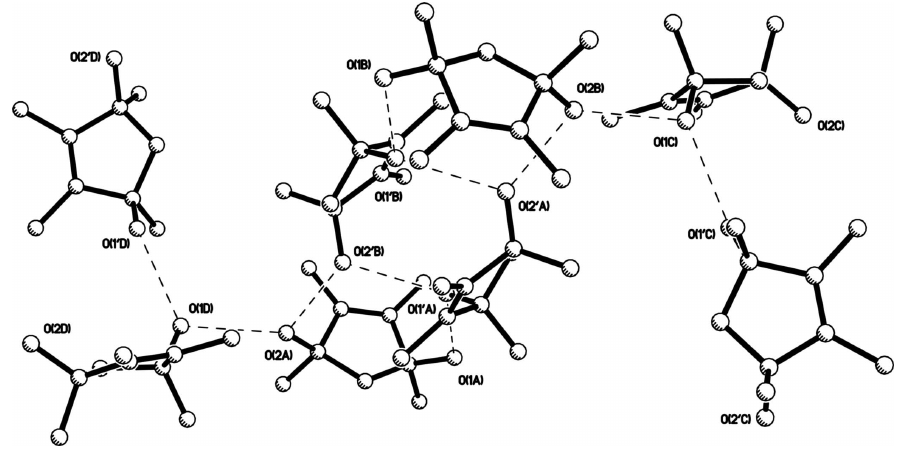
The hydrogen-bond